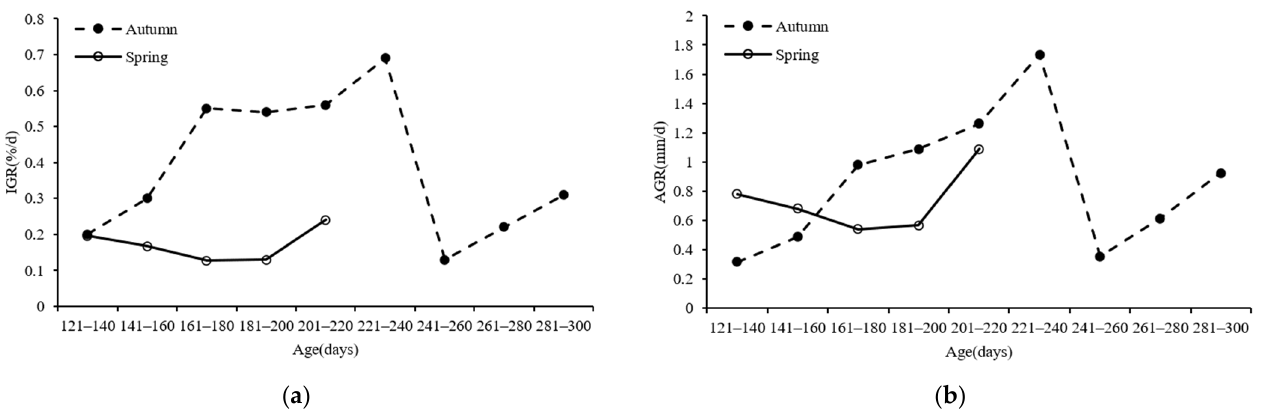
Figure 9. Relationships between the ML growth rate and age of S. oualaniensis samples: ( a ) IGR; ( b ) AGR.